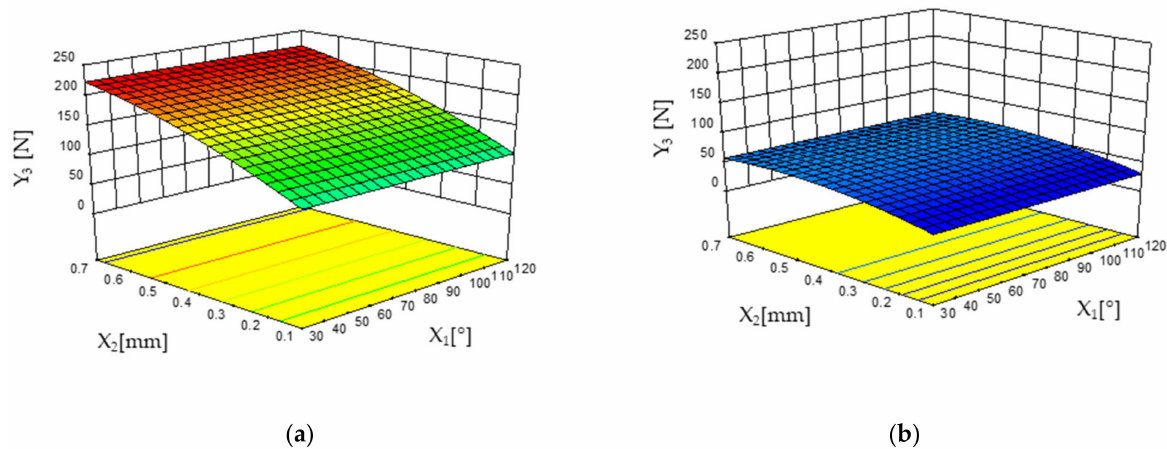
Figure 5. The 3D plots showing interaction effects of the drill tip angle (X 1 ) and tooth bite (X 2 ) on the thrust force (Y 3 ) when the holes were ‘performed’ with a flat drill ( a ) and with a helical drill ( b